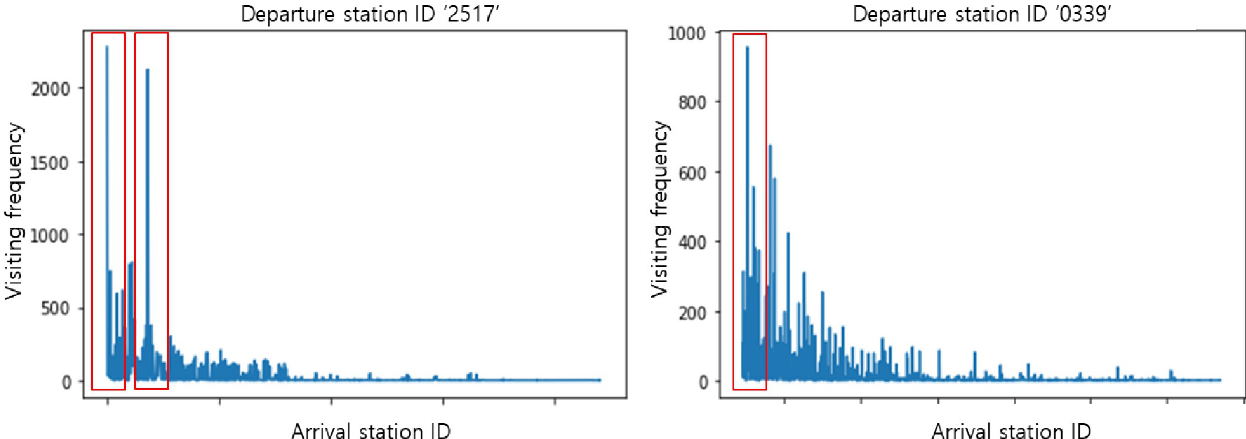
Fig 2. Numbers of data for stations that can be reached from departure stations (a) “2517” and (b) “0339”.